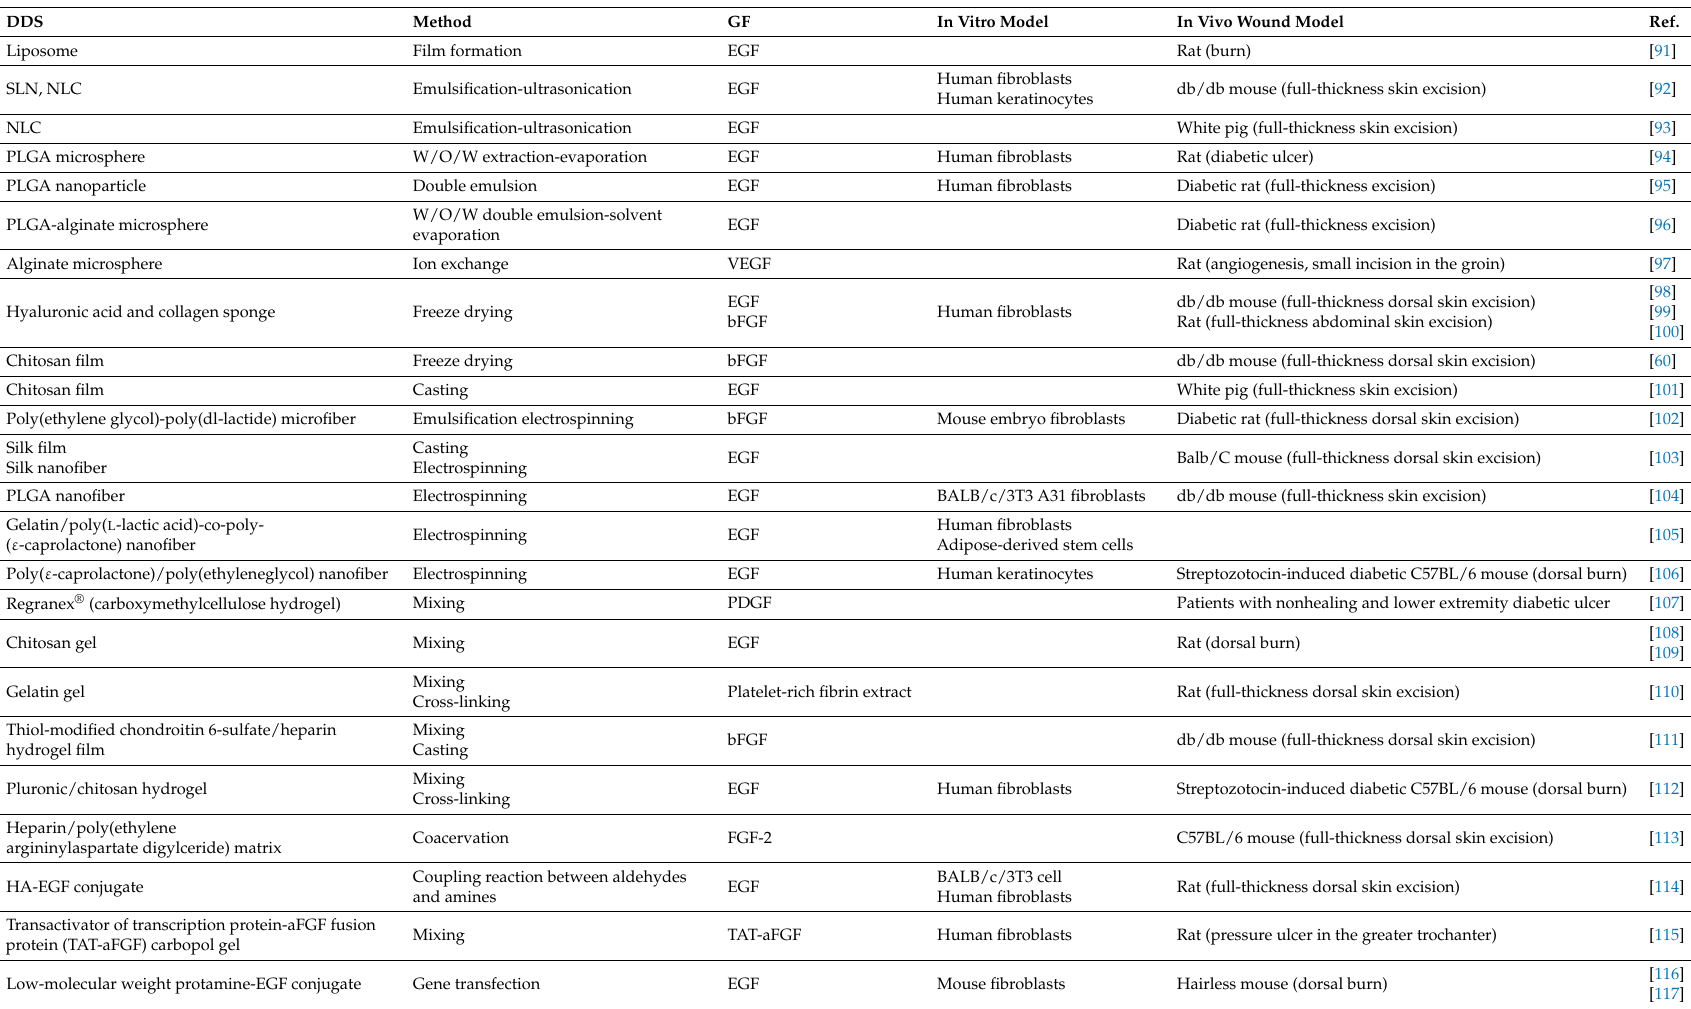
Table 2. Growth factor (GF) DDSs for wound healing and skin